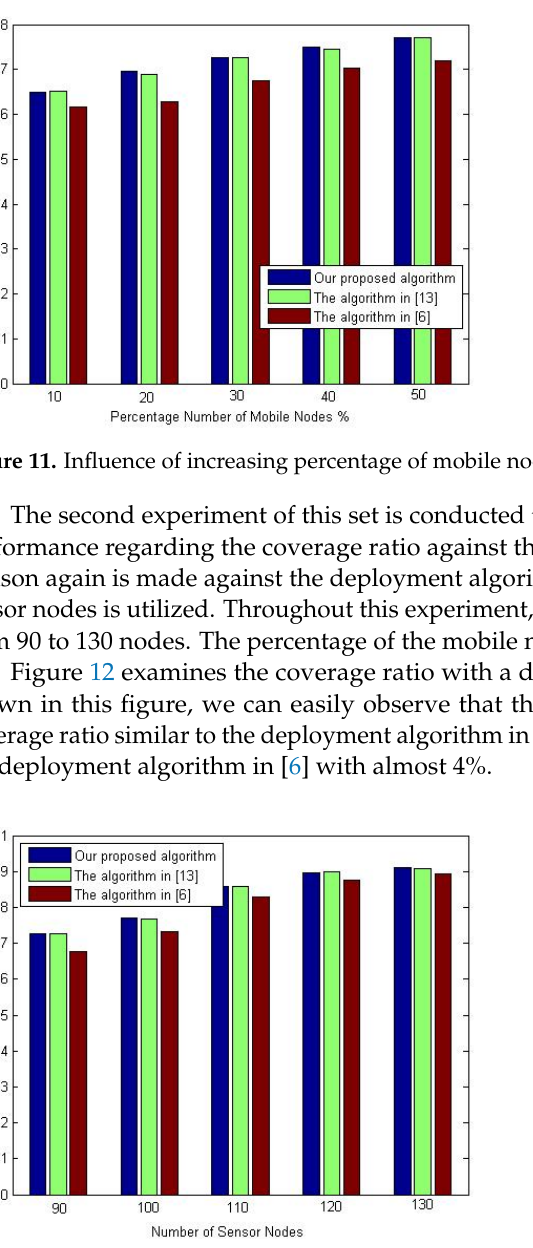
Figure 12. Influence of increasing number of sensor nodes on the coverage